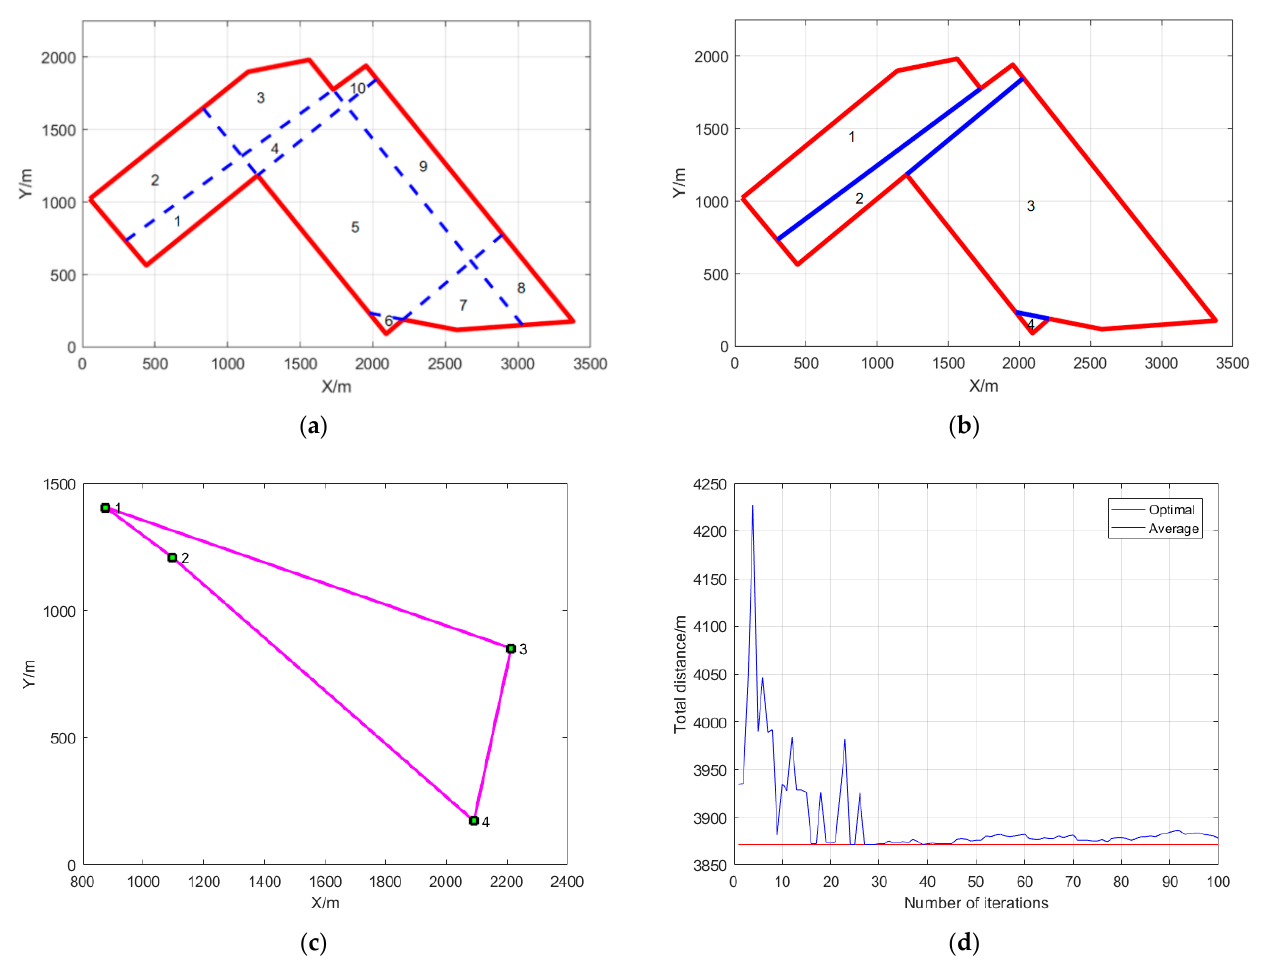
Figure 23. Decomposition and consolidation of detection area 2. ( a ) Decomposition of detection area 2; ( b ) consolidation of detection area 2; ( c ) schematic diagram of gravity center of detection area 2; ( d ) iterative process of the genetic algorithm.